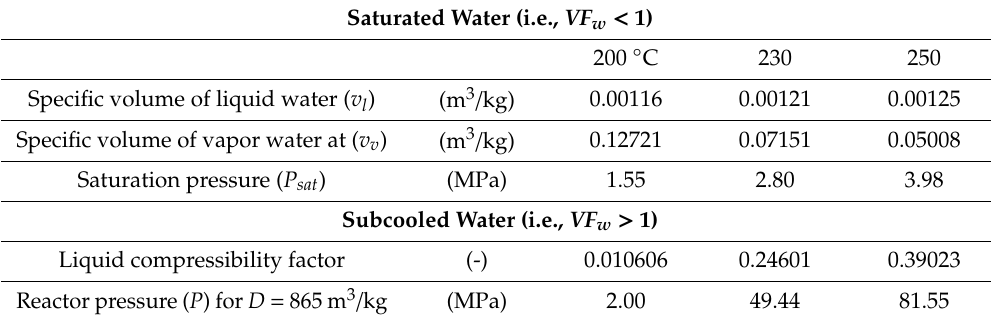
Table 1. Example calculations for the e ff ect of increasing the hydrothermal carbonization (HTC) temperature on reactor pressure for D = 865 kg / m 3 (values for saturated water properties taken from Lemmon et al.